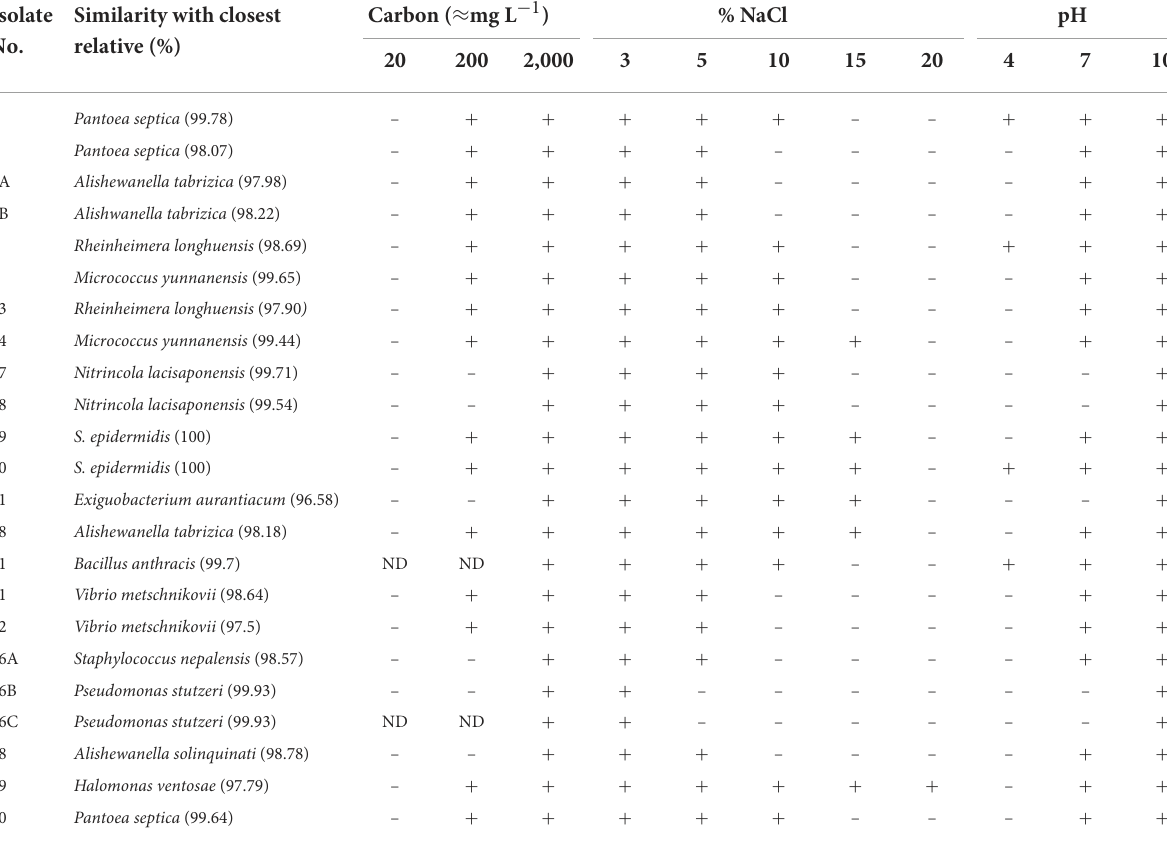
TABLE 3 List of copiotrophic organism and their growth response on different levels of carbon, NaCl, and pH. Isolate Similarity with closest No. relative